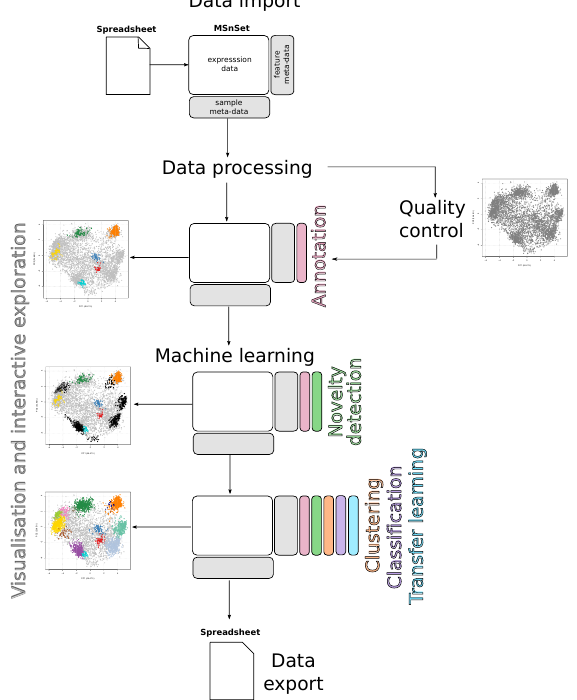
Figure 1. Schematic overview of the pRoloc pipeline from data import, through to data processing, machine learning and data